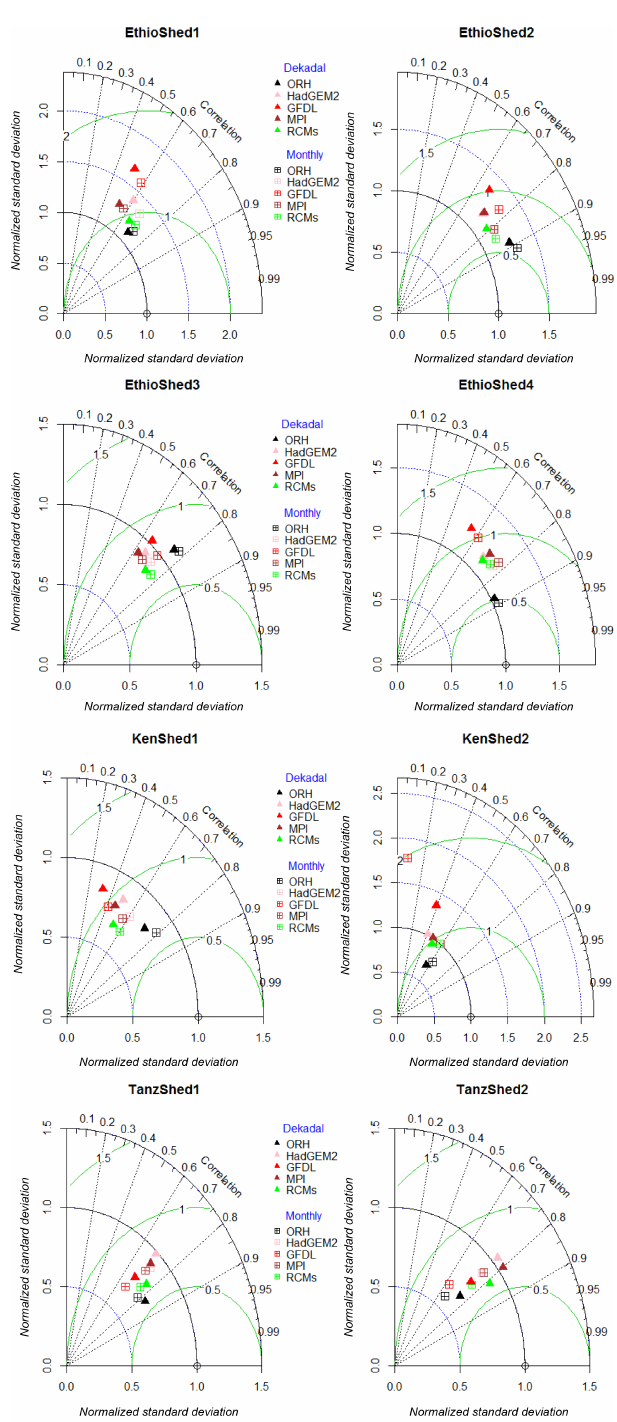
Figure 10. Taylor diagram displaying the agreement between ground observations and synthesized dekadal and monthly T min over eight validation areas of Ethiopia, Kenya, and Tanzania cov- ering the period of